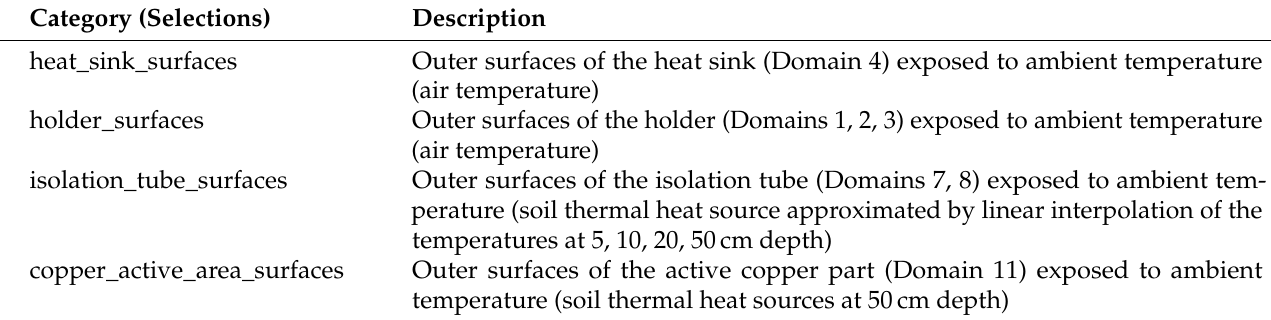
Table 5. Outer surface temperatures on the sensor